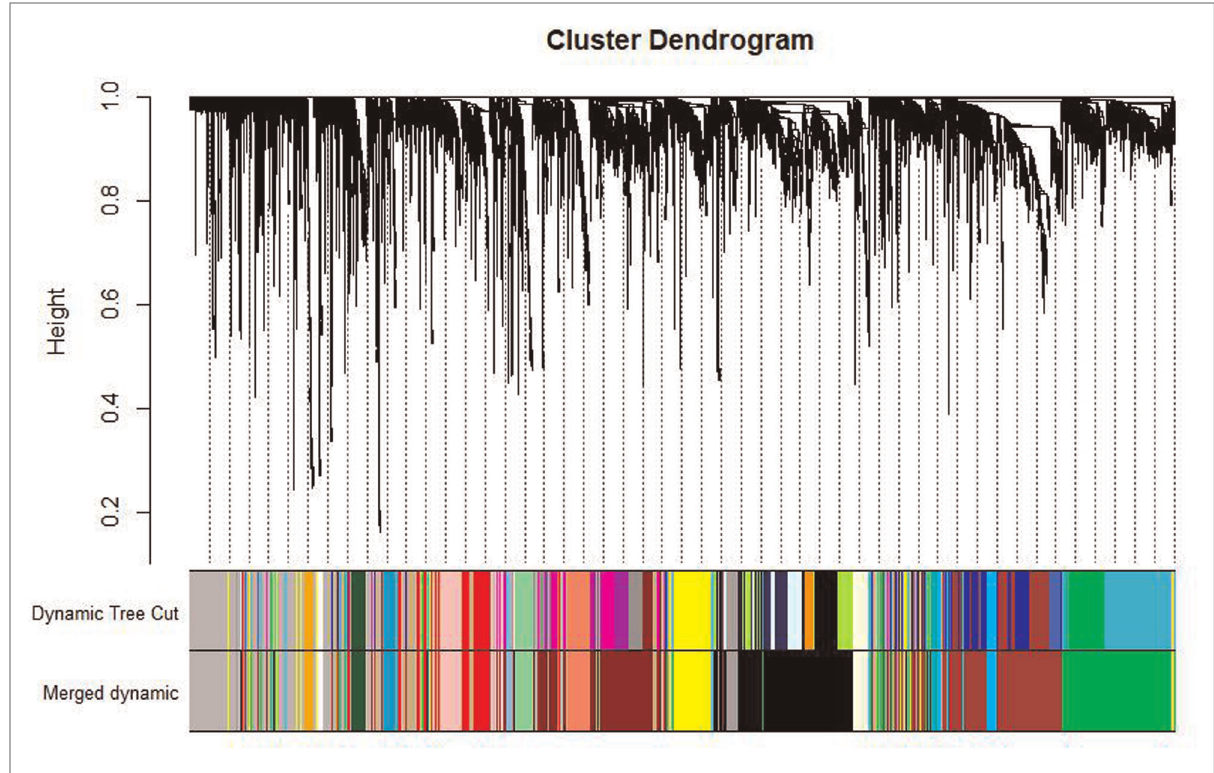
FIGURE 3 Gene dendrogram and module colors. After calculating eigengene, hierarchical clustering of modules, and merging the more similar modules, only 19 modules remain.